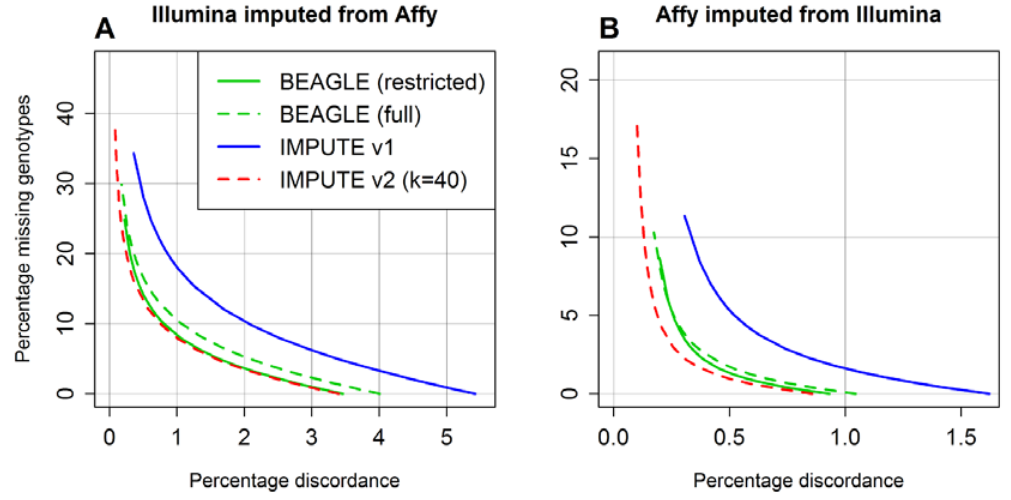
Figure 5. Percentage discordance versus percentage missing genotypes for full Scenario B dataset. (A) Results for masked Illumina genotypes imputed from Affymetrix genotypes in the study sample. (B) Results for masked Affymetrix genotypes imputed from Illumina genotypes in the study sample. Solid lines were obtained from the restricted Scenario B dataset (Figure 4) and are shown for reference; dashed lines were obtained from the full Scenario B dataset.